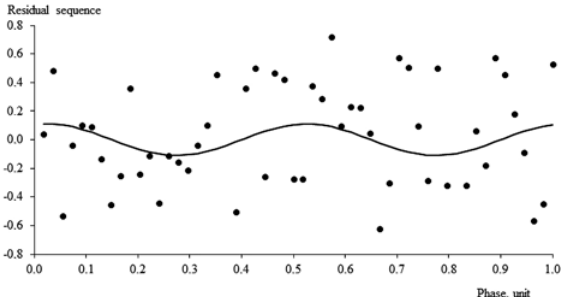
Fig. 6. Phase diagram of the residual